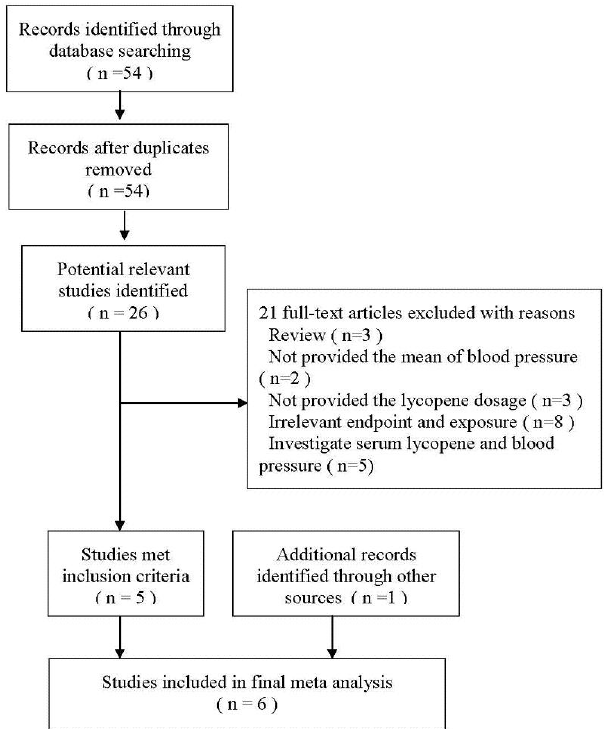
Figure 1. Flow diagram of paper